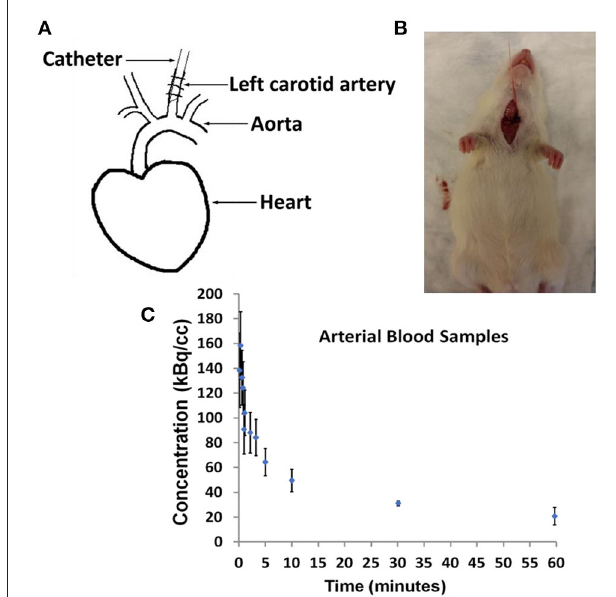
FIGURE 1 | Arterial Blood Sampling in Wistar–Kyoto (WKY) rats. (A) Sketch showing catheterization of the carotid artery. (B) Picture of a WKY rat during the experimental procedure. (C) Arterial Blood Sample measurements averaged over n = 5 WKY rats with standard error as a function of image acquisition time.